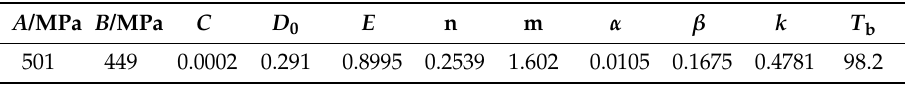
Table 3. Material constants for generalized J-C plasticity model for Al6063/SiC p /65p composites.